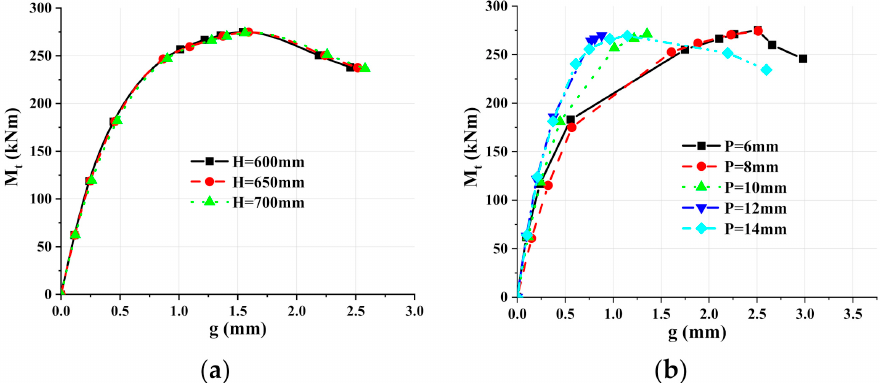
Figure 18. Moment-relative dislocation t curves of connections: ( a ) The height of inbuild component; ( b ) The thickness of inbuild component.